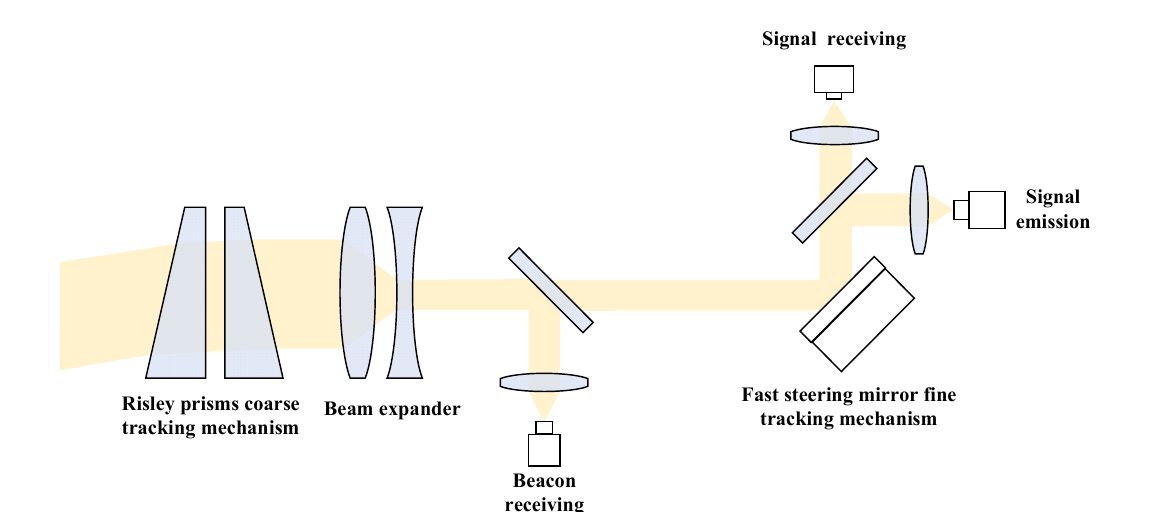
Figure 1. Optical layout of a laser communication system with a Risley prism coarse tracking mechanism.